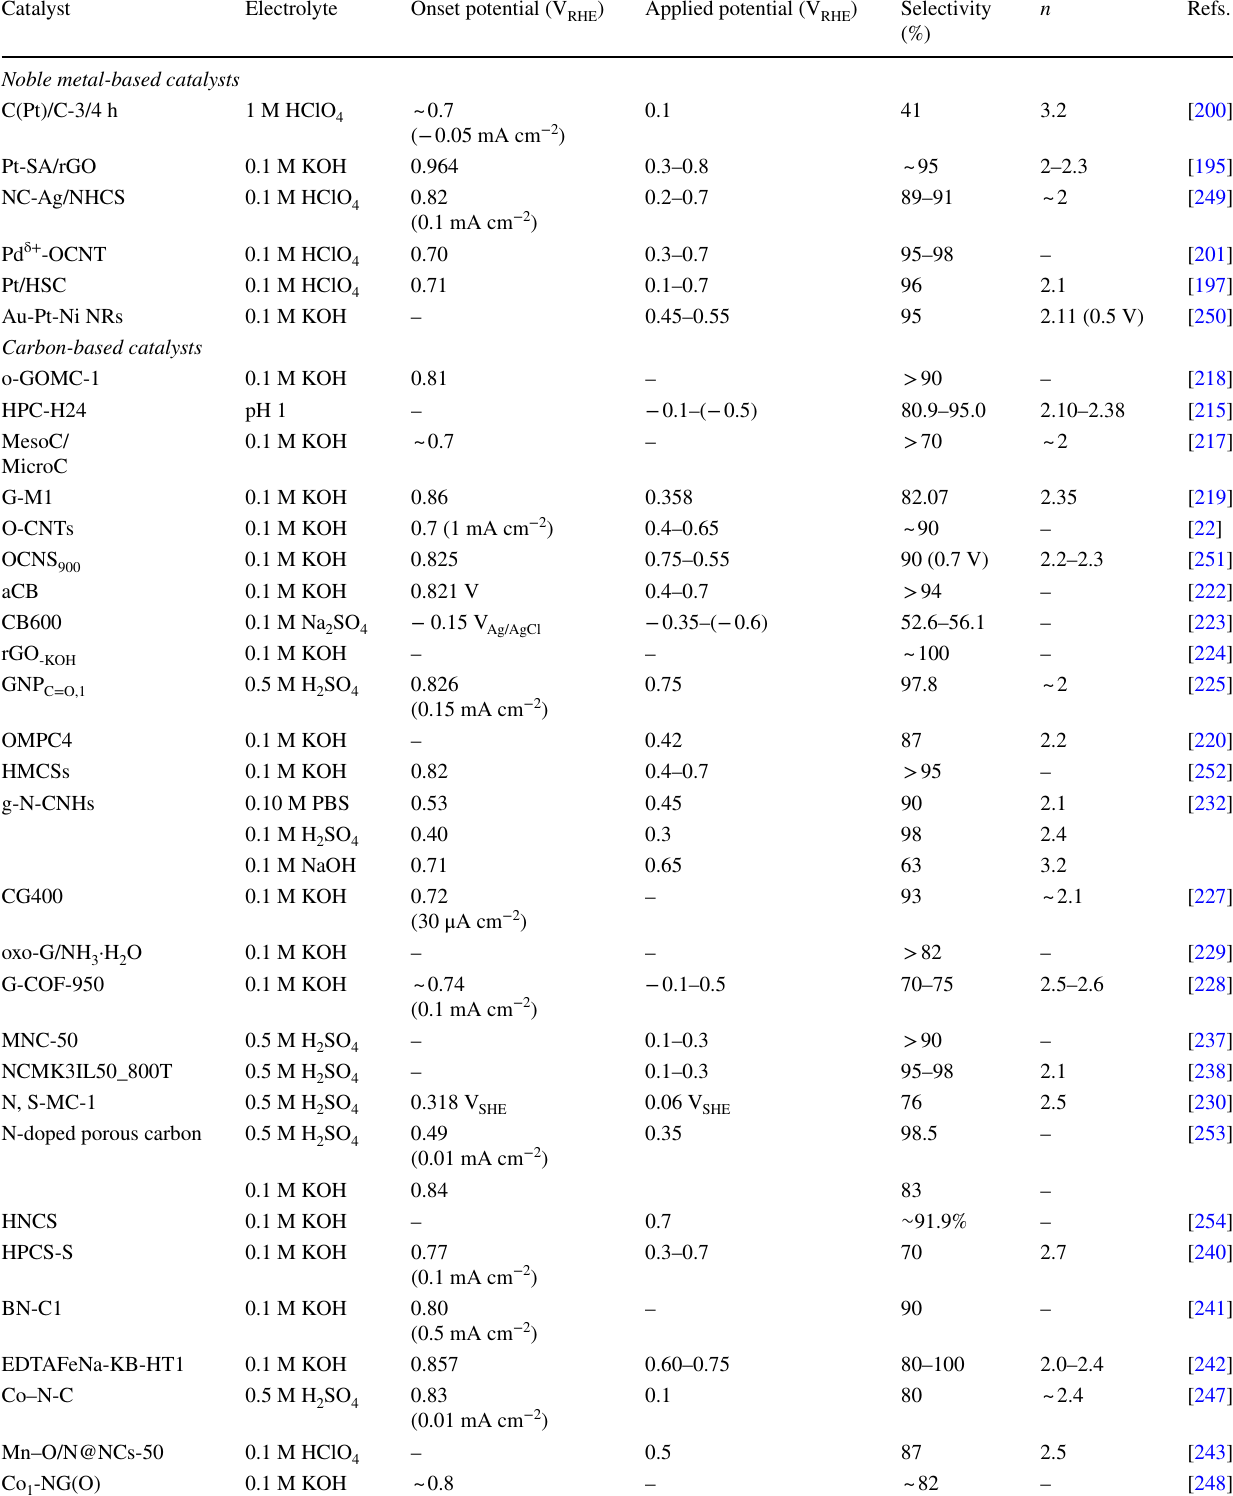
Table 3 Summary of electrocatalytic H 2 O 2 production via a 2e − ORR pathway Catalyst Electrolyte Onset potential (V RHE ) Applied potential (V RHE ) Selectivity